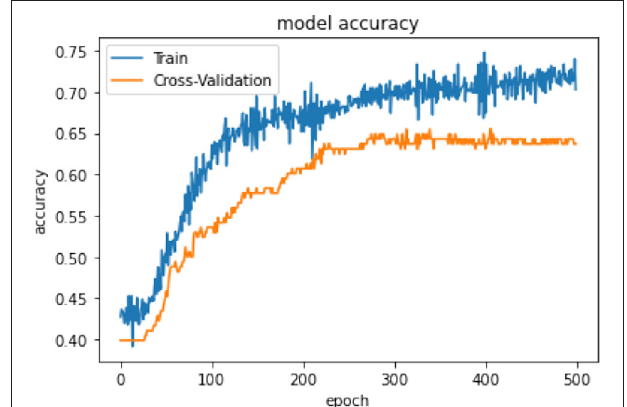
FIGURE 11 | ANN model loss-Main Land China.